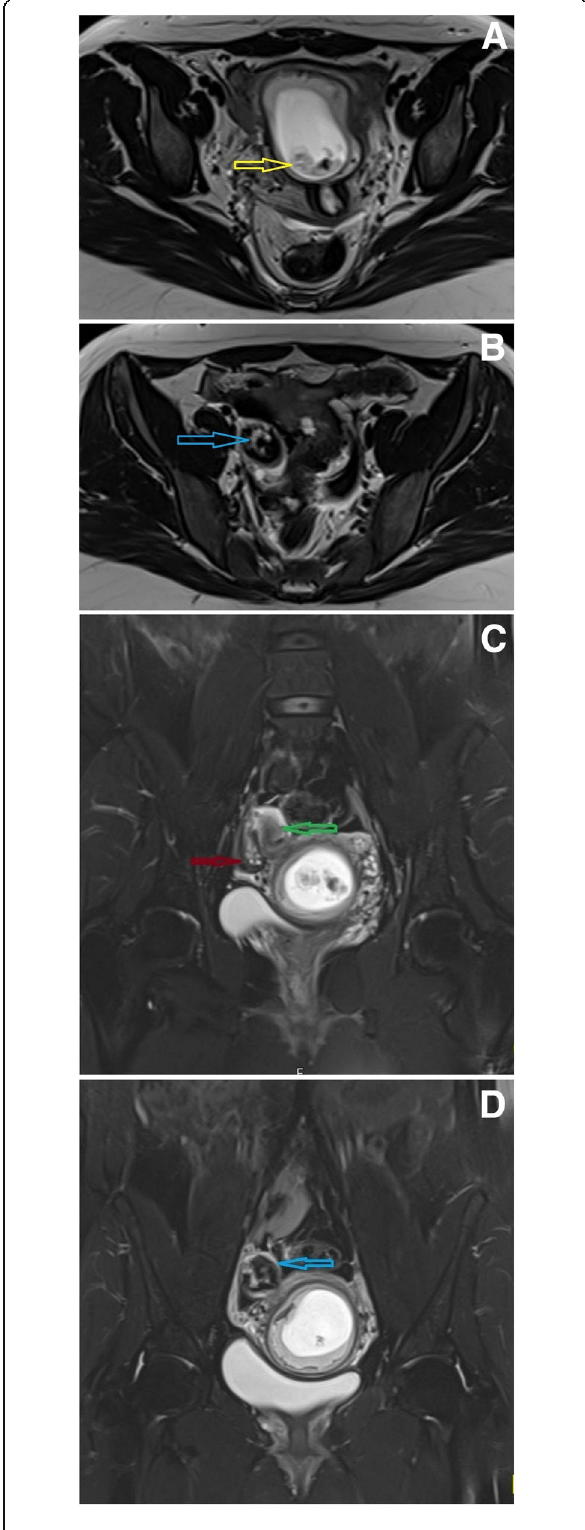
Fig. 2 MRI images ( a , b : Ax T2; c , d : T2 fat suppression) show the intrauterine fetus (yellow arrow) as well as a well-defined right adnexal lesion (blue arrow) with mixed signal with a high signal at its thick wall. Pelvic collection (green arrow). Note the normal right ovary (red